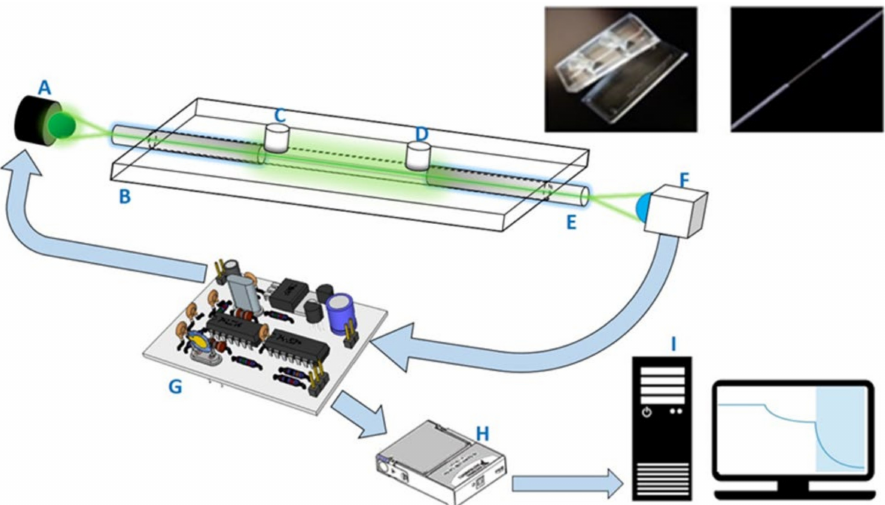
Figure 1. The schematic illustration of FOPPR biosensor system used in this study: A. light-emitting diode (LED); B. sensing chip; C. sample inlet port; D. sample outlet port; E. sensing fiber with one unclad segment; F. photodiode; G. circuit board with LED driver and photoreceiver amplification cir- cuit; H. data acquisition card; I. personal computer. In the upper right, the left imbedded photograph shows the upper and lower slides of a sensor chip, while the right photograph shows the sensing fiber with one unclad